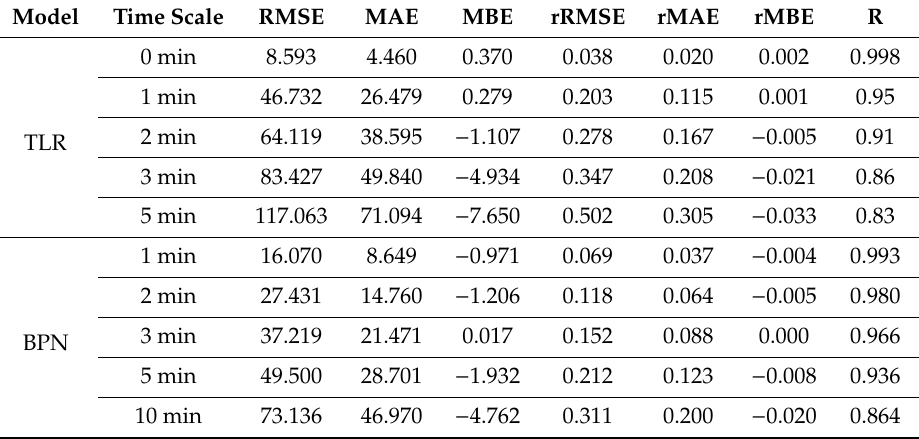
mean absolute error, rMBE: relative mean bias error.